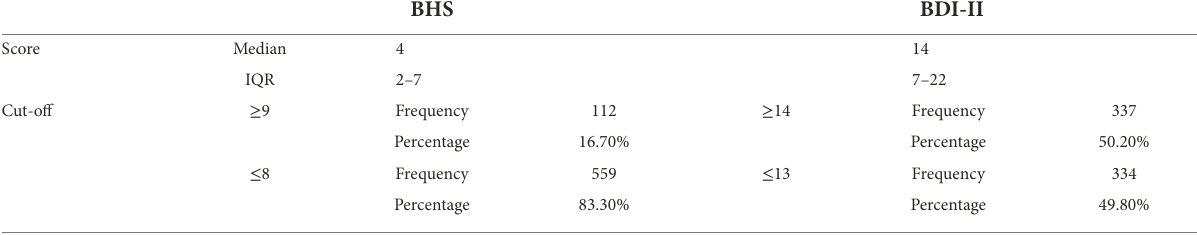
TABLE 3 BHS and BDI-II score/cut-off statistics.